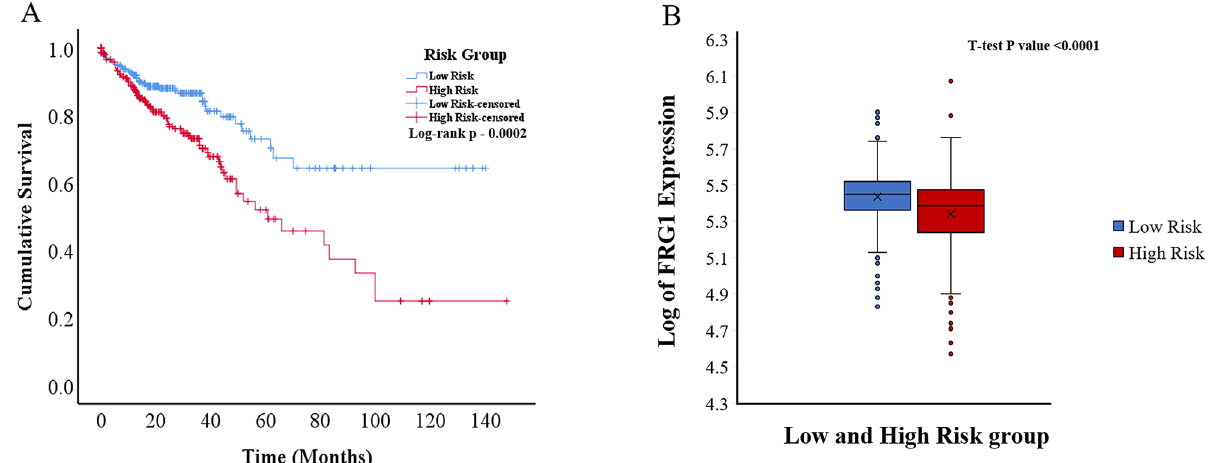
Figure 5. Kaplan–Meier plot and box plot of colorectal cancer patients risk groups based on the multigene model. ( A ) KM plot showing overall survival in low-risk and high-risk patient groups (Log-rank test p-value = 0.0002). The blue line shows the low-risk group and the red line shows the high-risk group. ( B ) Box plot showing log of FRG1 expression level in low and high-risk groups. The Y-axis represents the log of FRG1 expression and the X-axis shows the The top 20 FRG1 correlated genes (Supplementary Table S2), with r s cutoff ≥ 0.539, were used to generate the multivariate cox regression model using TCGA-LIHC (The Cancer Genome Atlas Liver Hepatocellular Carcinoma) and TCGA-CHOL (The Can- cer Genome Atlas Cholangiocarcinoma) datasets. The final model had 16 genes (Table 3) where the hazard ratio of FRG1 was 0.18 (95% CI 0.034–0.948, p = 0.043) for liver cancer patient’s death. Next, to determine the effect in the multigene model, the patients were divided into the low-risk group (n = 231) and high-risk group (n = 231) based on the median risk score. The AUC for this risk model was 0.616 (Supplementary Fig. S3). A significant (p = 0.0001) difference in OS was observed between the two groups (Fig. 6A). Comparison of FRG1 mRNA expression between the high-risk group and low-risk group (Fig. 6B) showed significantly (p < 0.0001) higher expression in the low-risk group. FRG1 knockdown in HEK293T reduces expression of HPF1, RPL34, and EXOSC9. To validate the knockdown of FRG1 in HEK239T cells, we performed Western blot and qRT-PCR analysis, which confirmed